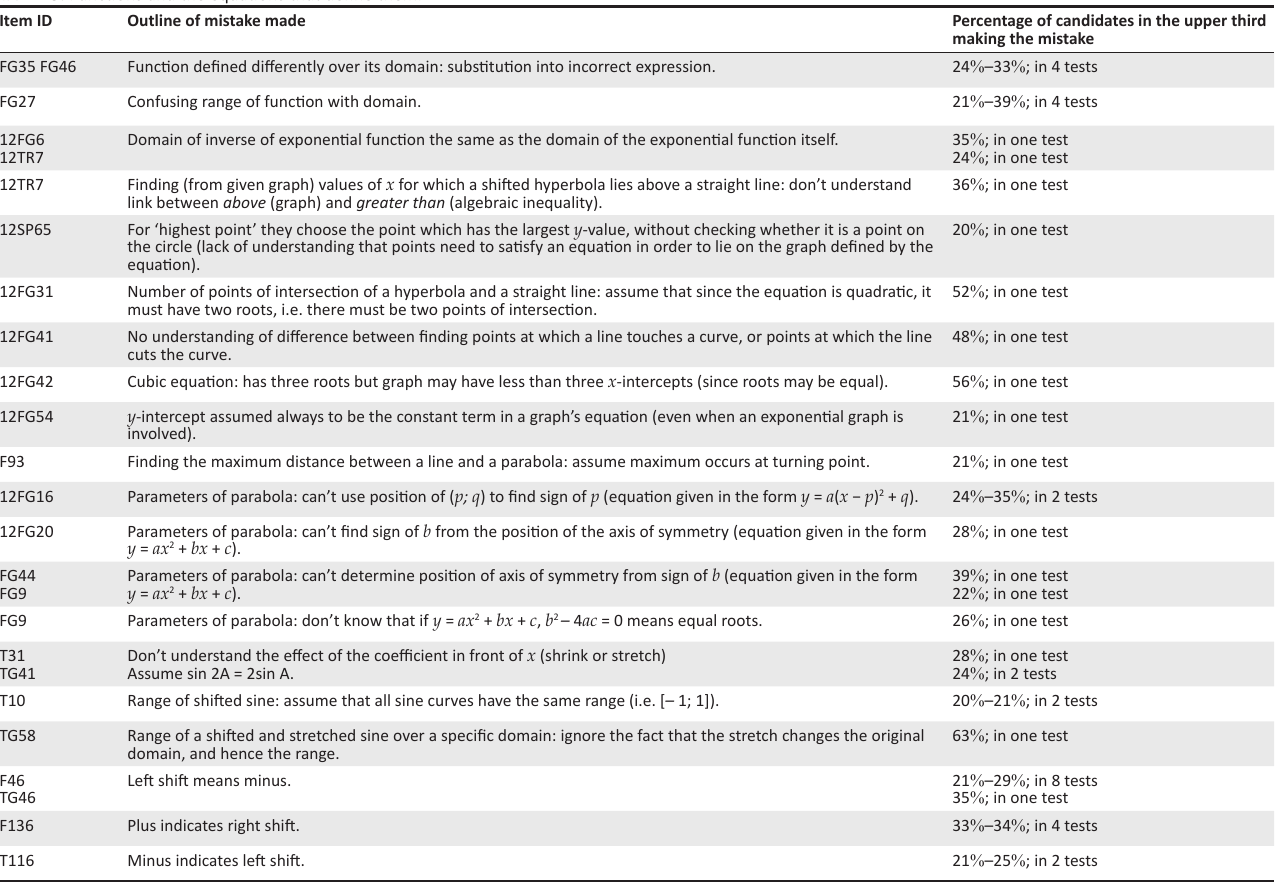
TABLE 5: Functions and the equations that define them. Item ID Outline of mistake made Percentage of candidates in the upper third